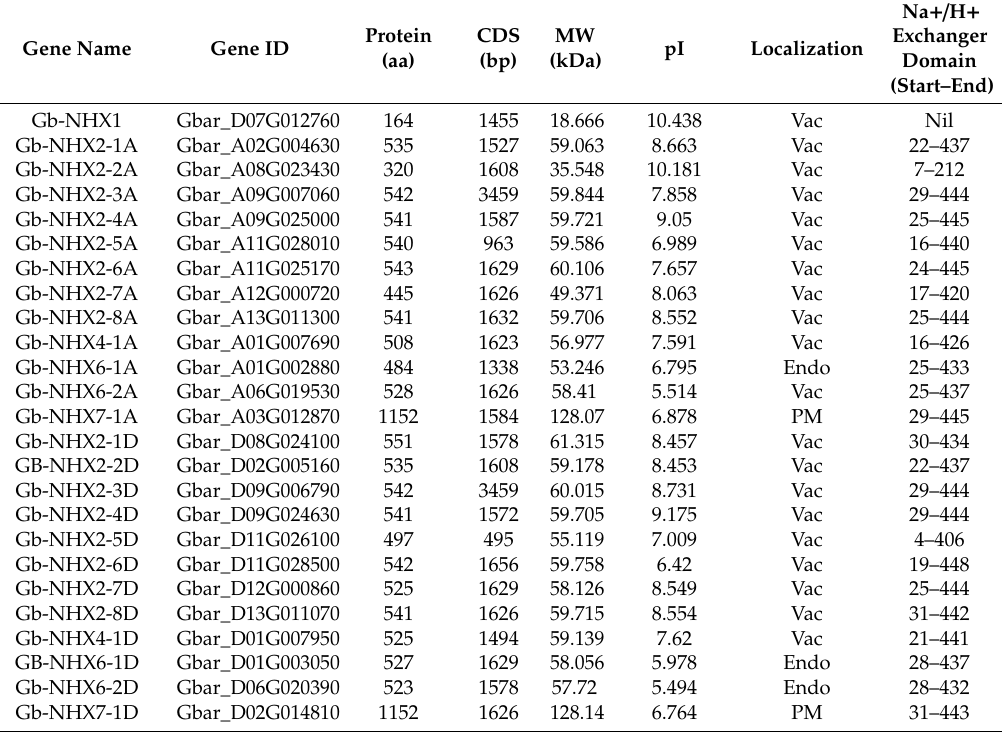
Table 1. Characteristics of the G. barbadense sodium-proton antiporter (NHX) transporters.